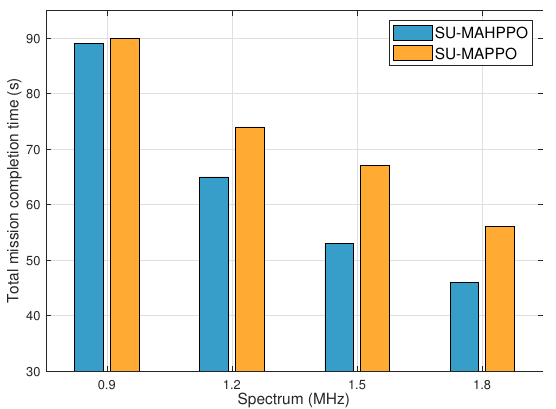
Figure 8. Total mission completion time with different SNR thresholds.